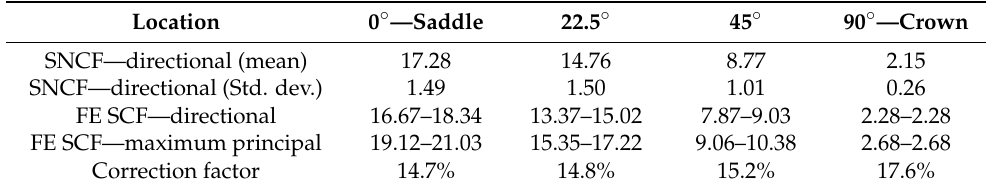
Table 2. Experimental measured strain concentration factors (SNCF), FE validation and SCF correc- tion factors from directional stresses perpendicular to the weld toe to principal stresses.